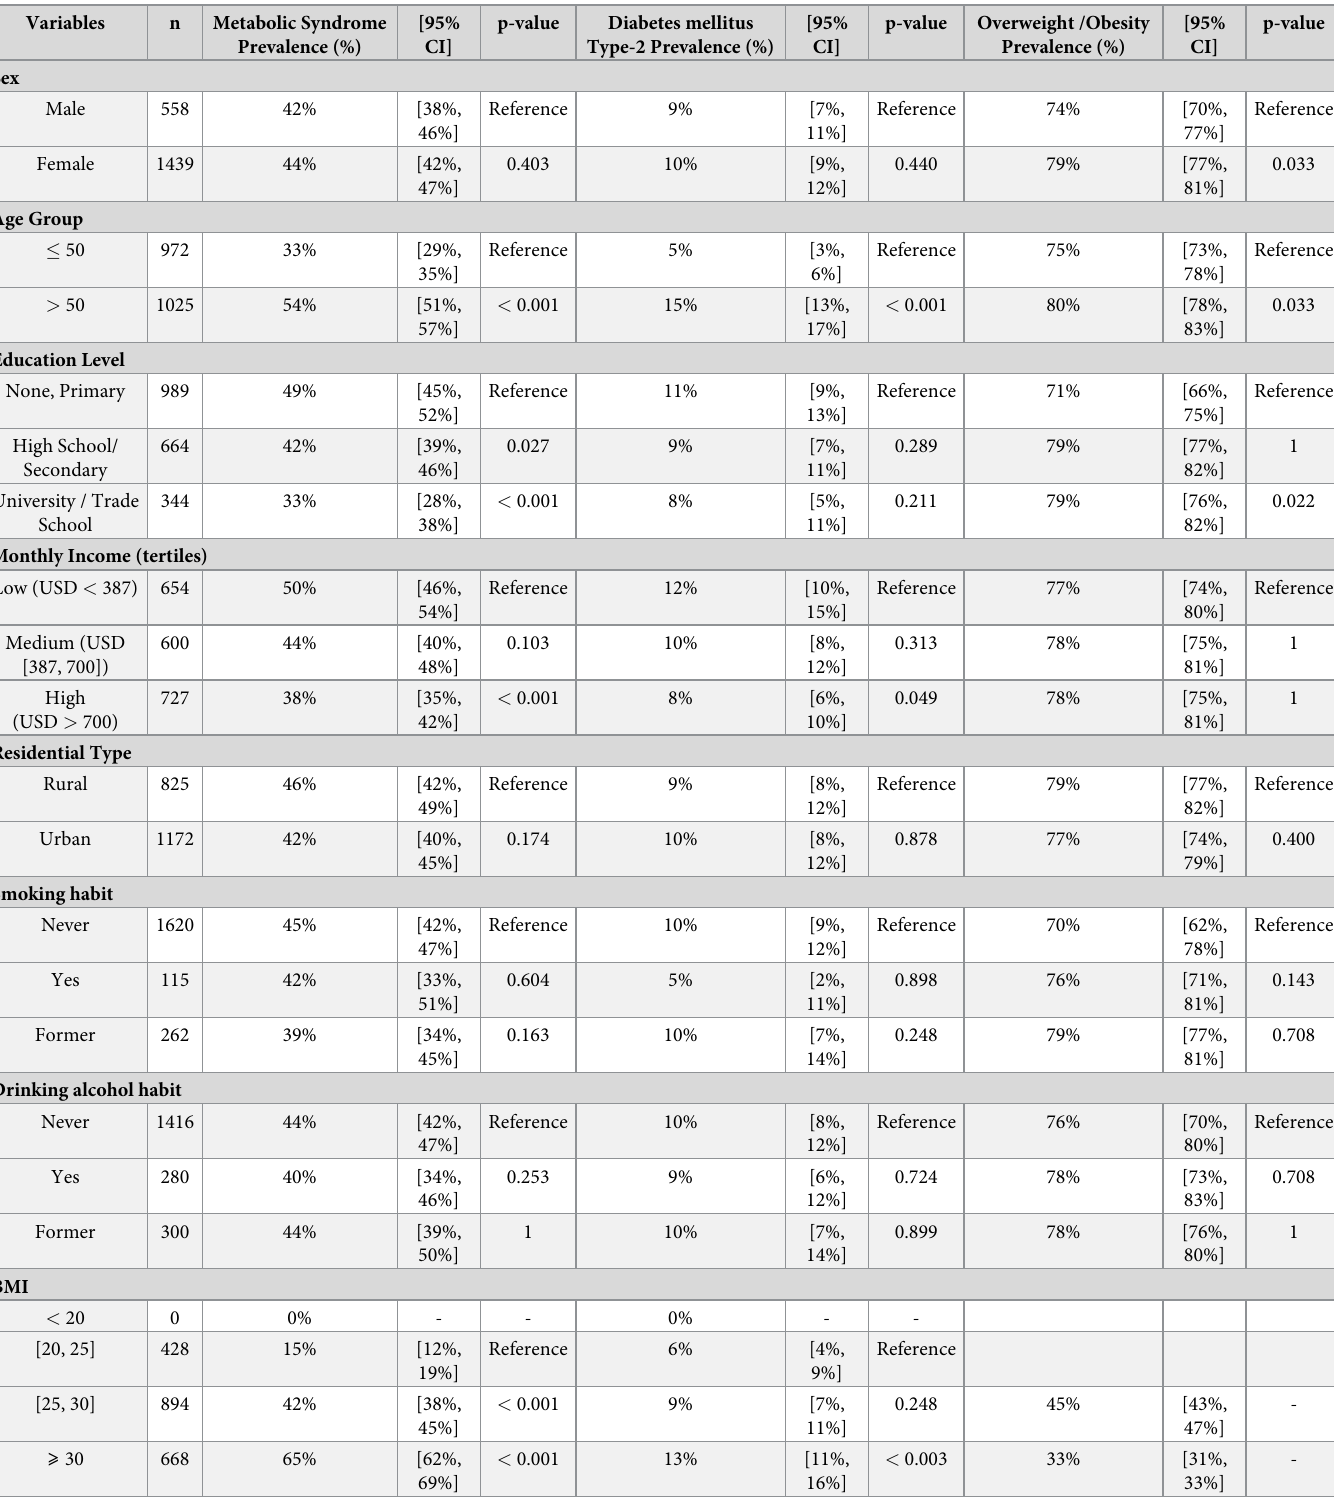
Table 1. Sociodemographic and anthropometric variables for individuals with metabolic syndrome, type-2 diabetes, and excess weight.